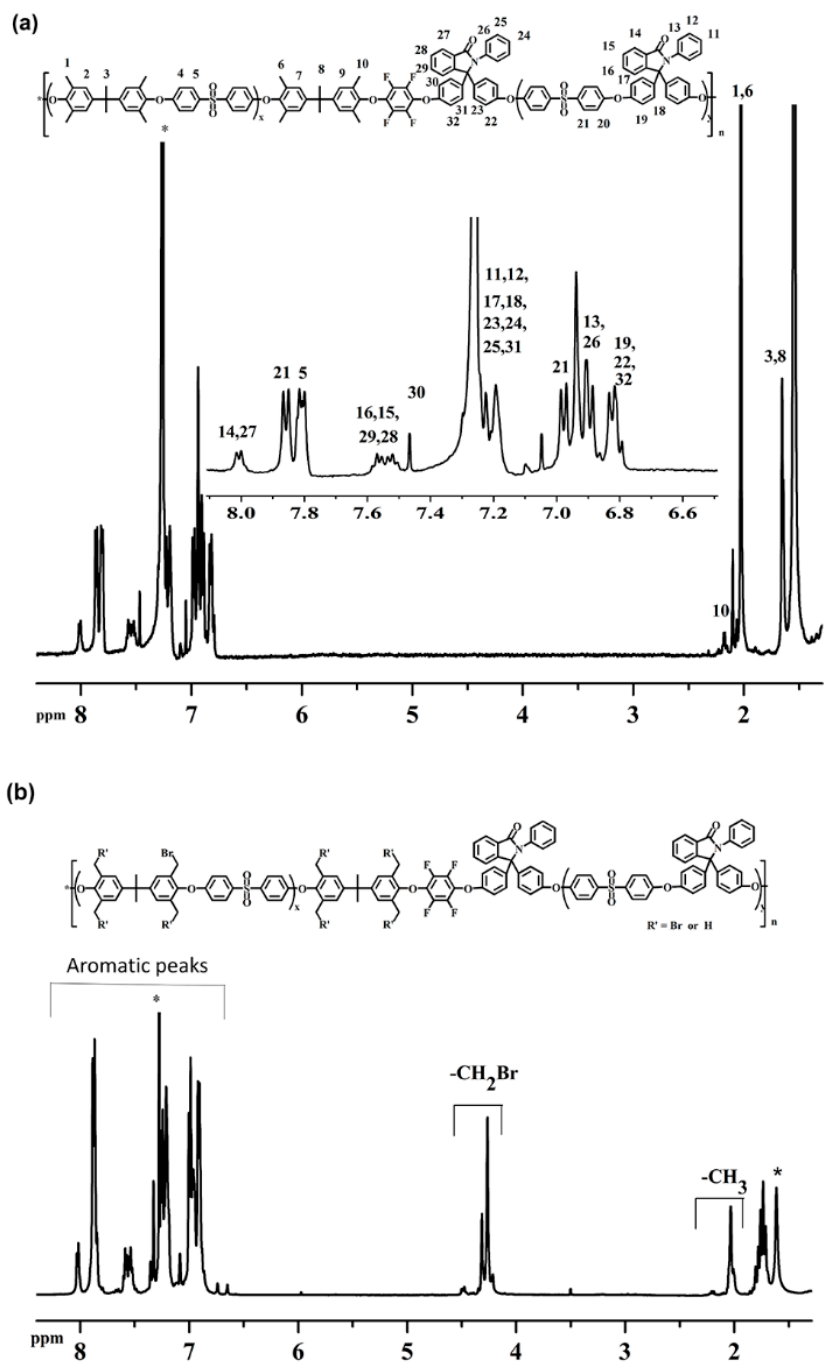
Figure 2. 1 H NMR spectra of ( a ) cardo-PES and ( b ) cardo-PES-Br in CDCl 3 at 25 ◦ C. * indicates solvent and moisture peaks.